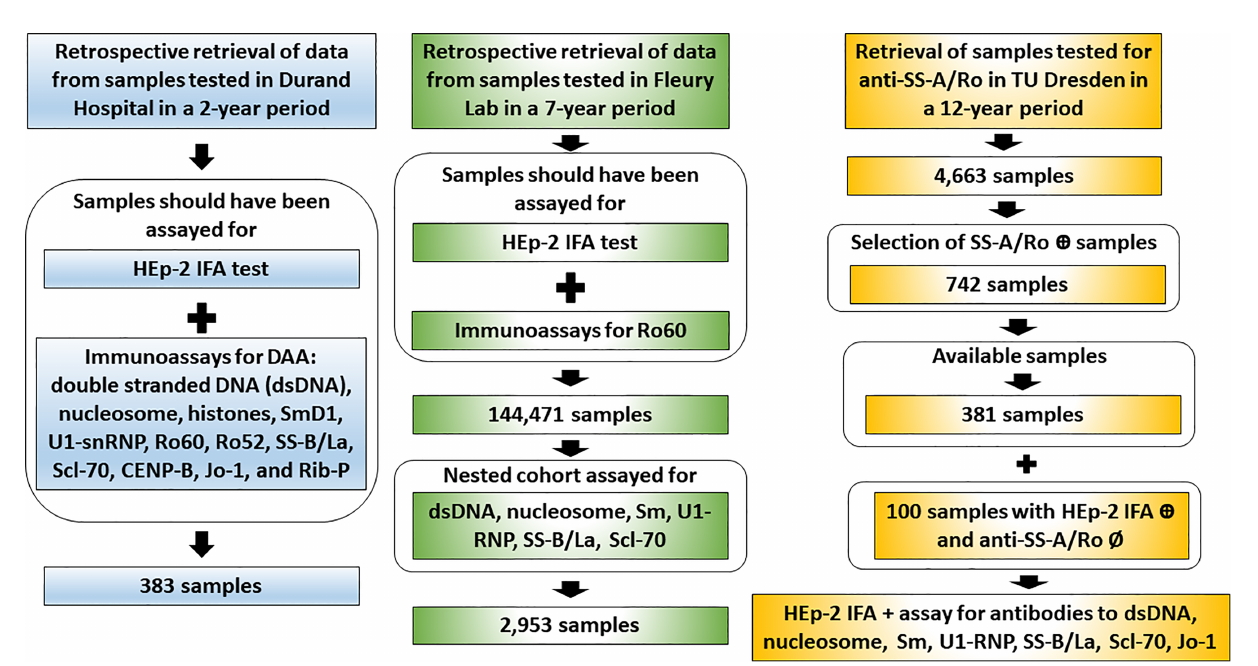
FIGURE 2 | Work fl ow of data retrieval and sample analysis in the three independent clinical laboratories. The Argentinian center (Durand Hospital) and the Brazilian center (Fleury Laboratory) provided retrospective data obtained from databanks of samples assayed in the day-to-day operation. From the serum bank, the German center (Technical University Dresden) retrieved samples recorded as positive or negative for anti-SS-A/Ro and prospectively assayed them for disease-associated autoantibodies